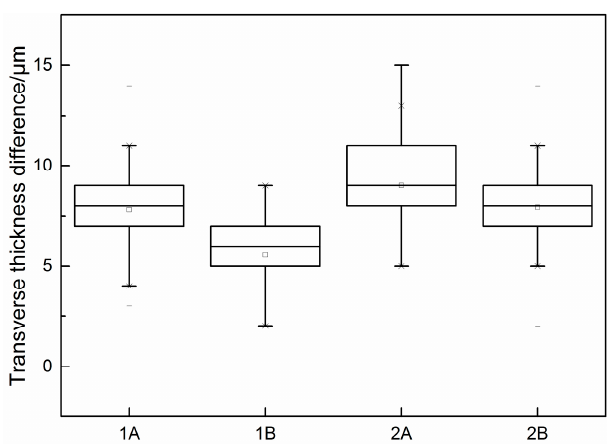
Figure 12. Comparison of work roll shape curves.